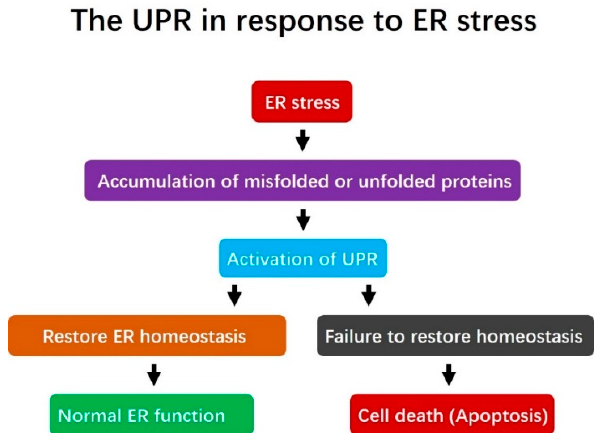
Figure 1. The role of the unfolded protein response (UPR) in addressing Endoplasmic Reticulum (ER) stress. Under ER stress, misfolded or unfolded proteins accumulate in the ER. This triggers activation of the UPR, which is a pro-survival response designed to alleviate the accumulation of misfolded proteins, restore ER homeostasis and re-establish normal ER function. However, if the UPR fails to restore ER homeostasis, cell death (apoptosis) is induced.